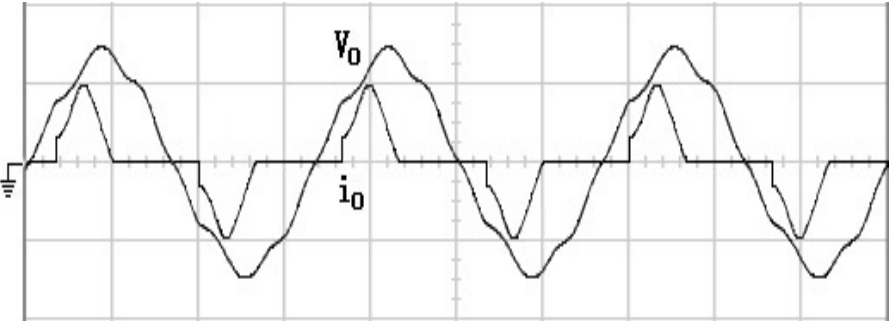
Figure 9. Experimental output waveforms under rectifier load obtained using the proposed approach (vertical: 100 V/division and 20 A/division, horizontal: 5 ms/division).